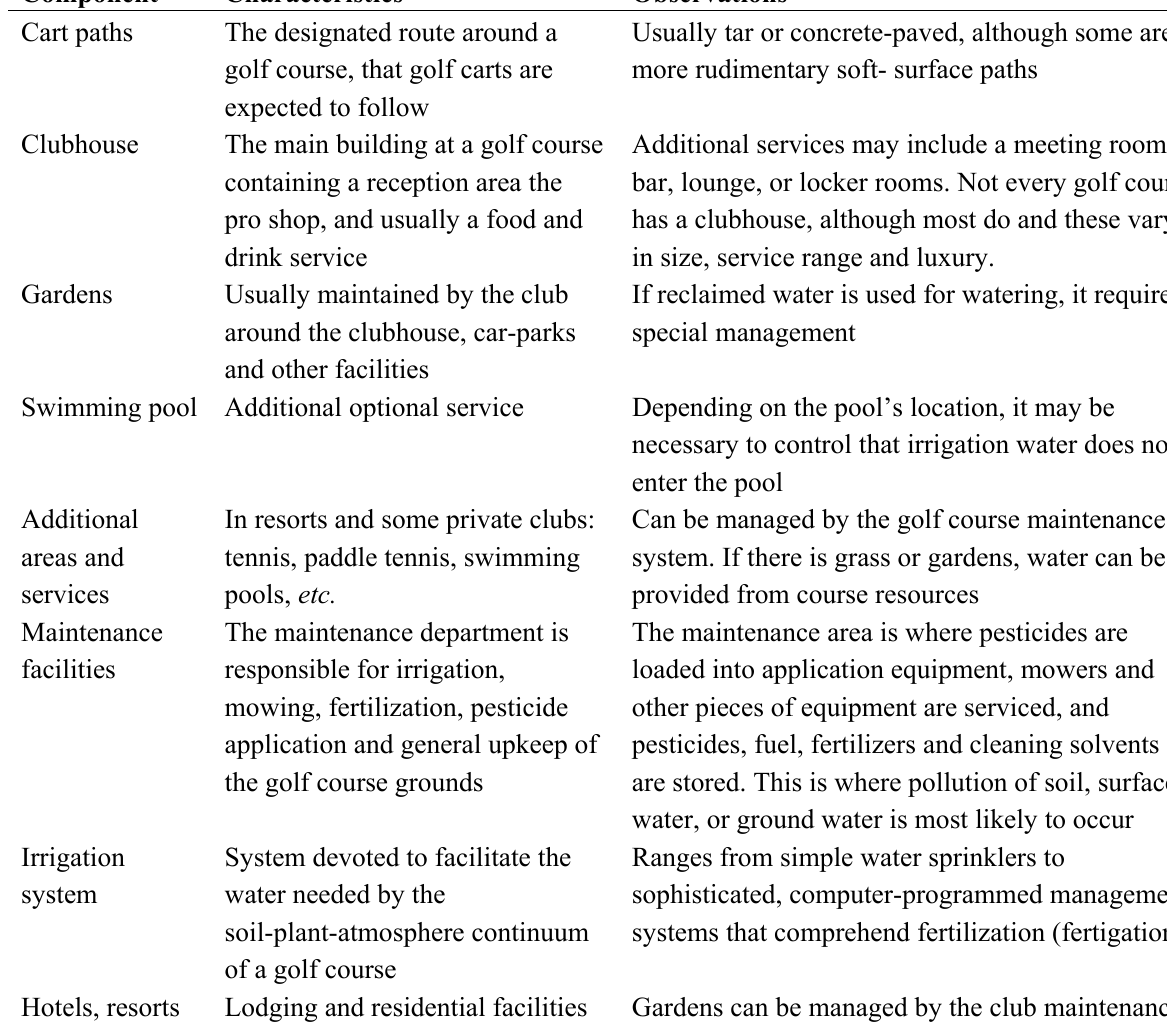
Table 2. Components of a golf course not directly related to the sport.